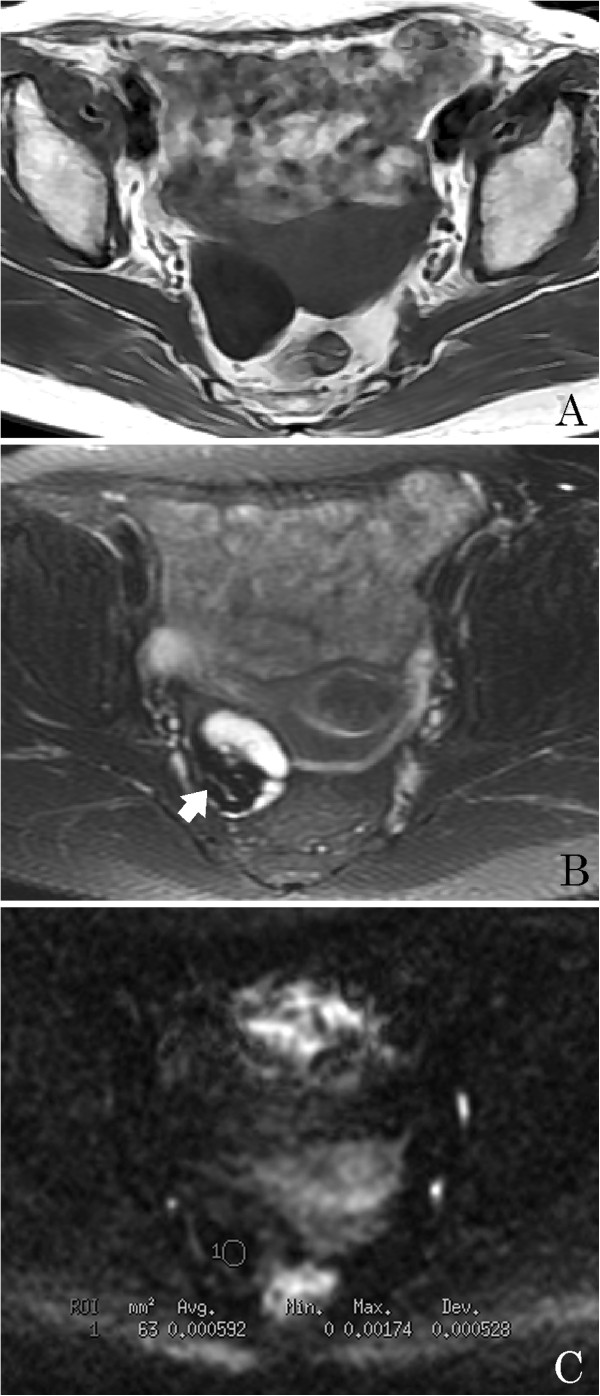
A 67-year-old woman with an ovarian cystadenofibroma. (A) Axial T1-weighted image shows a right ovarian mass with a hypointensity. (B) Axial T2-weighted image reveals that the solid part of the mass is hypointense (arrow) and the cystic component is hyperintense. (C) Axial diffusion-weighted imaging (DWI) reveals that the solid part of the mass has a very low signal intensity (circle 1, apparent diffusion coefficient (ADC) = 0.592 × 10-3 mm2/s).